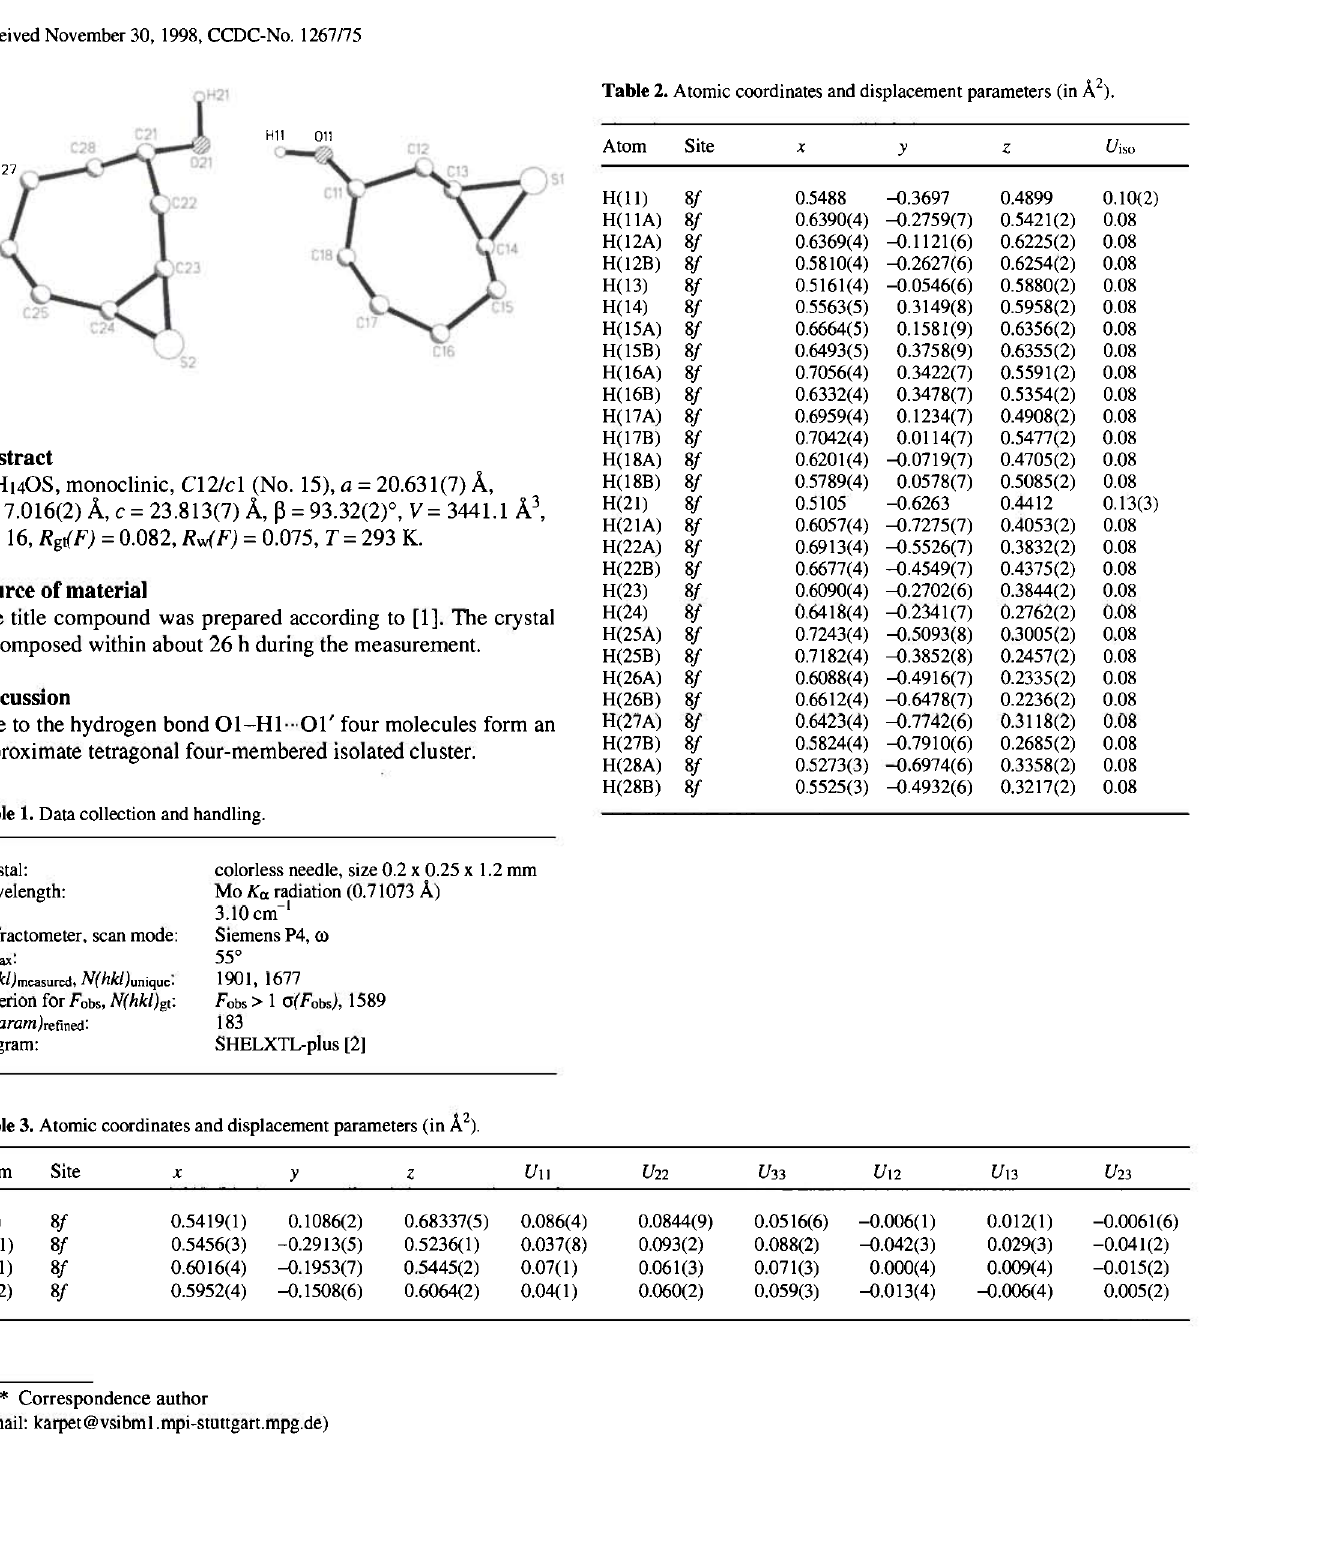
Table 2. Atomic coordinates and displacement parameters (in Ä 2 ).